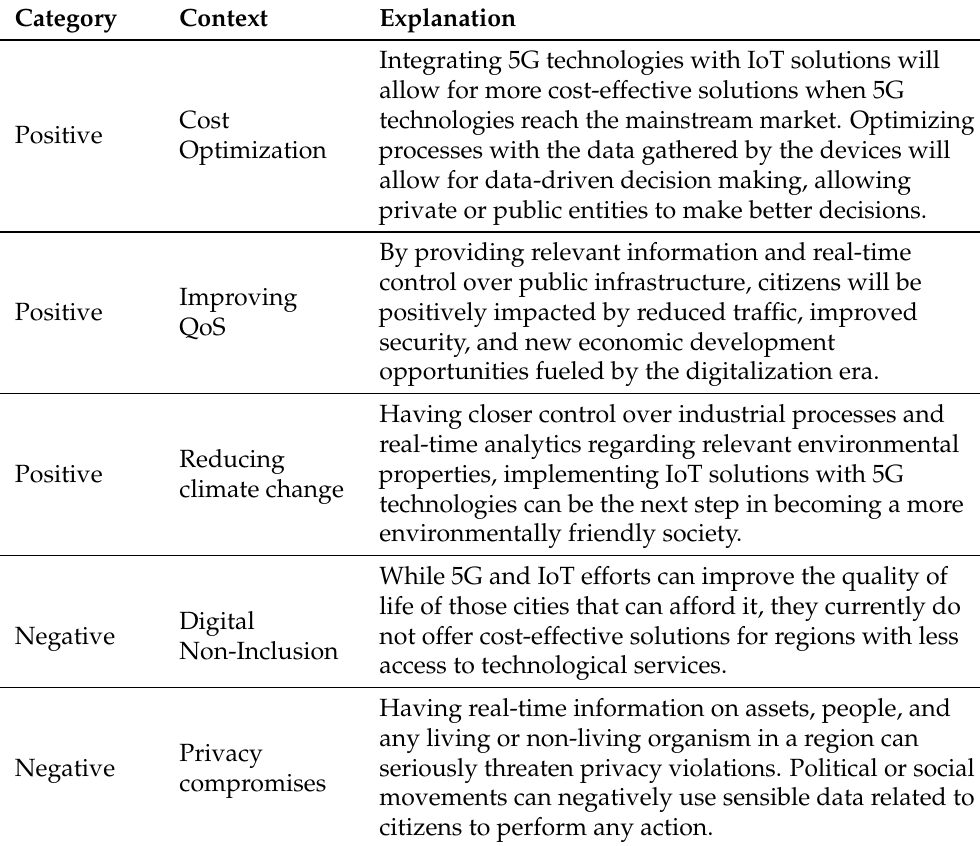
Table 10. Explanation of the positive or negative impact in 5G and